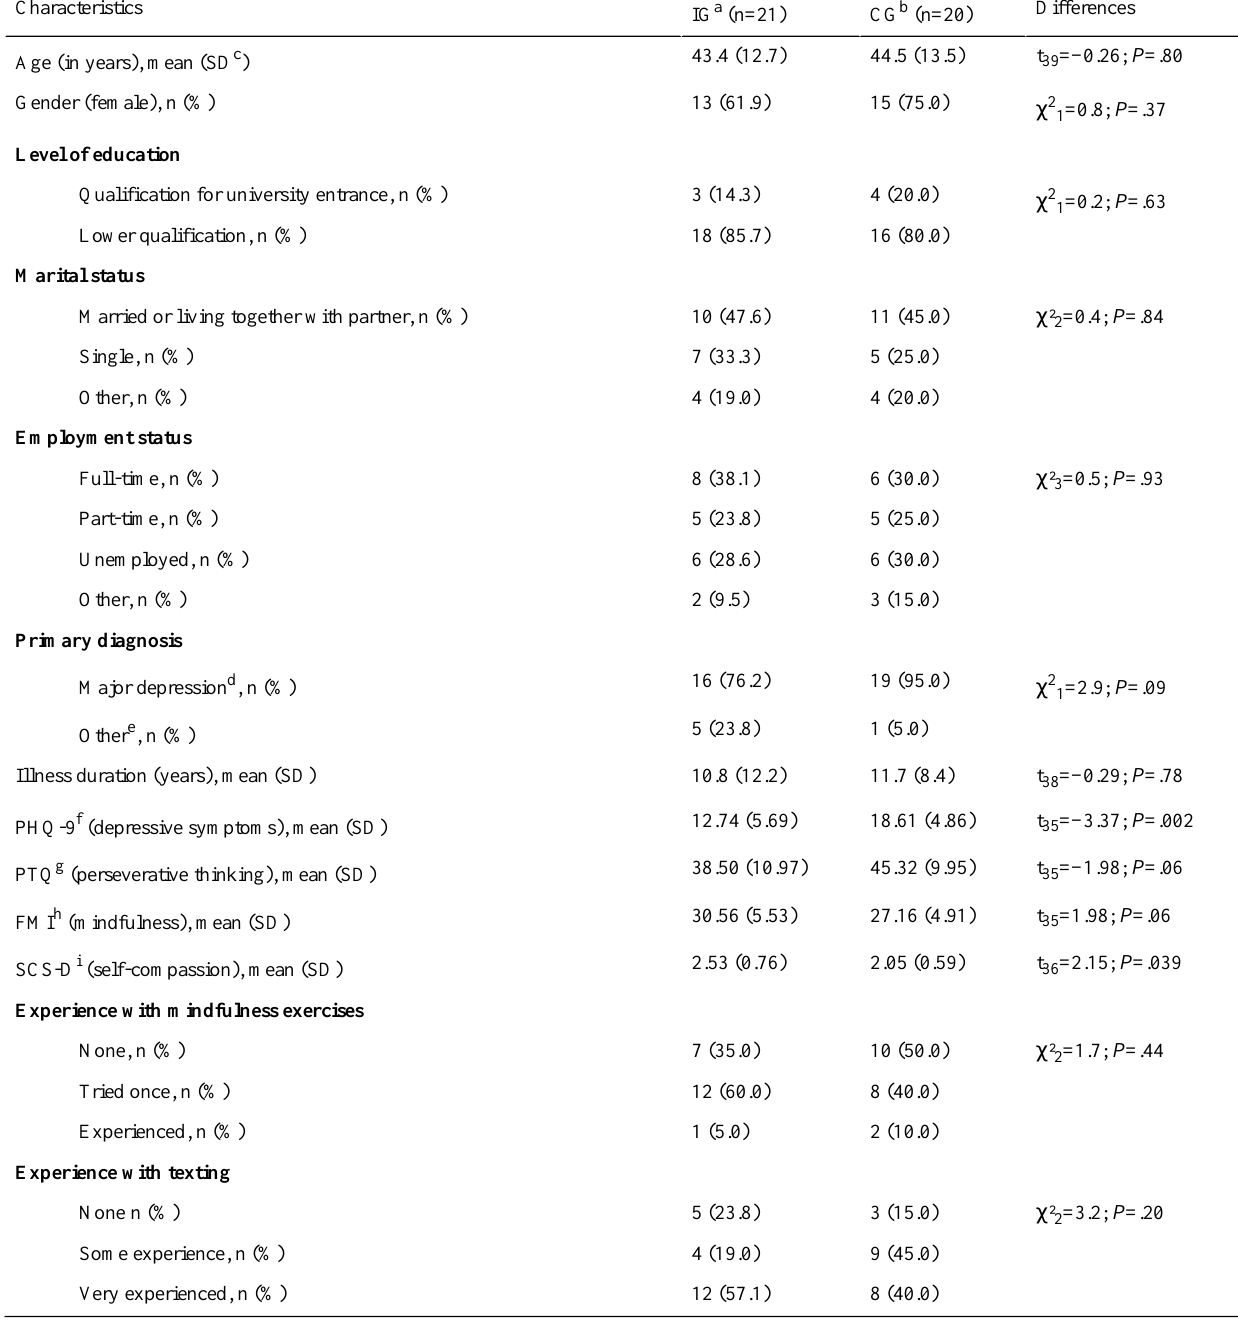
Table 1. Characteristics of study participants.